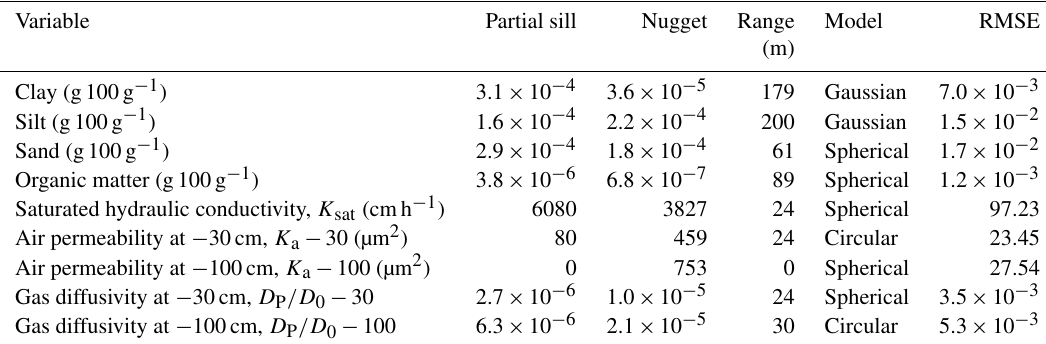
Table 2. Partial sill, nugget, range, Kriging interpolation model, and root mean square error (RMSE) for semivariograms for each interpolated map. All interpolations were performed with ESRI ArcMap